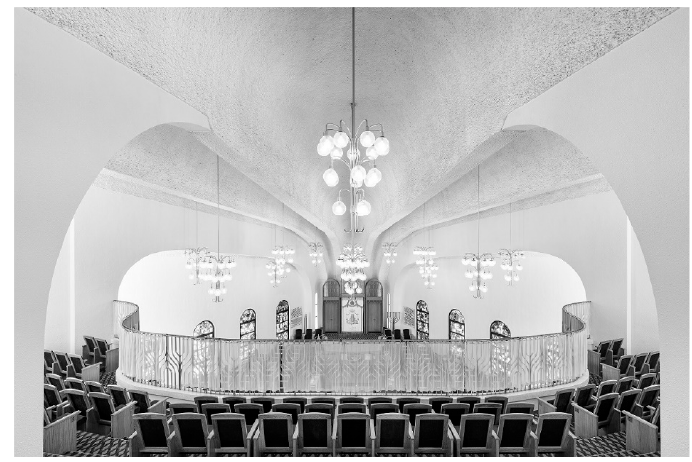
Figure 11. Heichal Yehuda Synagogue, Tel Aviv. View from the women’s section. Eli Singalovski, Heichal Yehuda #1 , 2018. Archival pigment print, 100 cm × 67 cm. Used with permission.